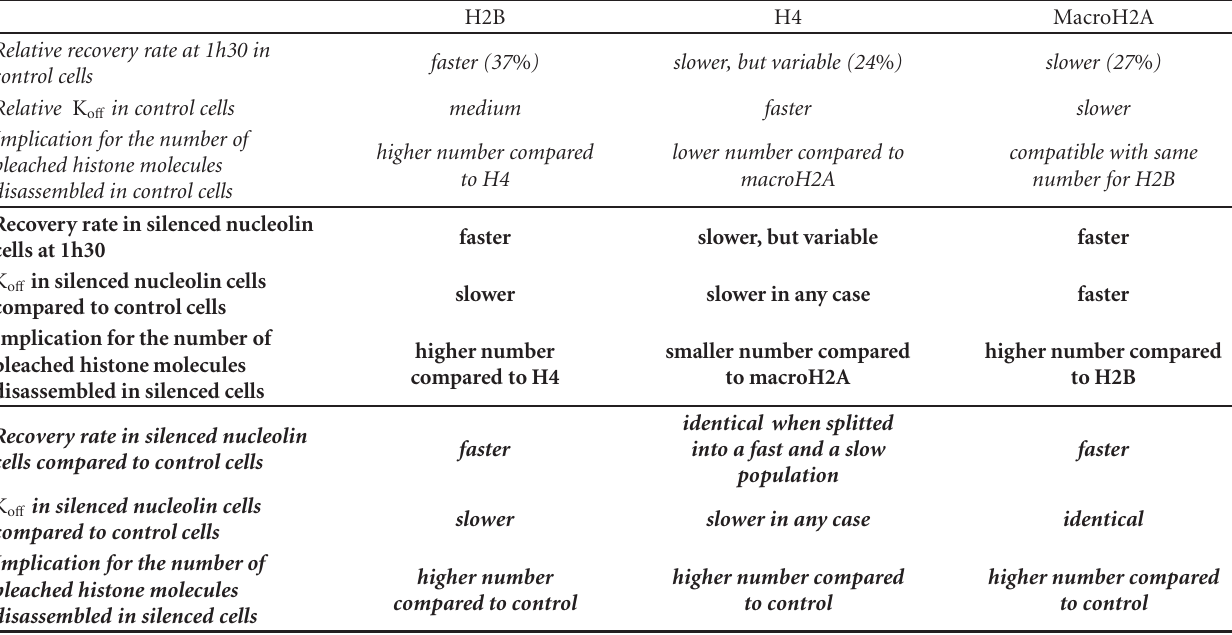
Table 1: Summary of the FRAP results obtained for recovery rates and dissociation constants (K o ff ) extracted from Figures 2–5 for H2B, H4, and MacroH2A. The analysiswas subdivided into 3 categories: control cells (in italic), silenced cells (bold), and comparison between silenced cells and control cells (italic-bold). In addition to the 2 parameters directly extracted from the results, implication of a third parameter was obvious to explain the observed recovery rates, the number of bleached histone molecules disassembled. H2B H4